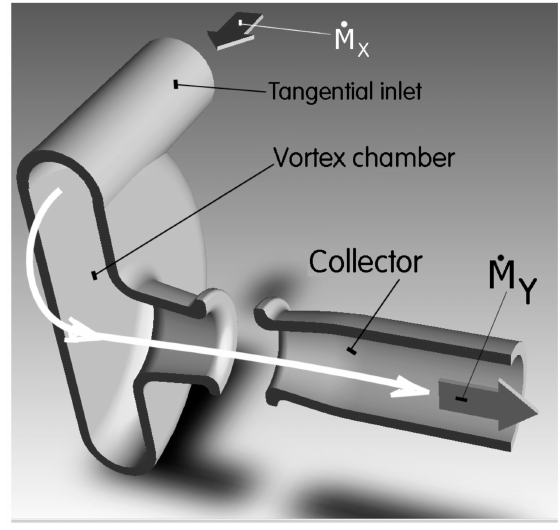
Figure 4. Pulse shaper based on the idea of vortex spin-up according to [26]. The front part is shown here cut o ff by a meridian cutting plane. The white flow line represents the beginning of the inlet